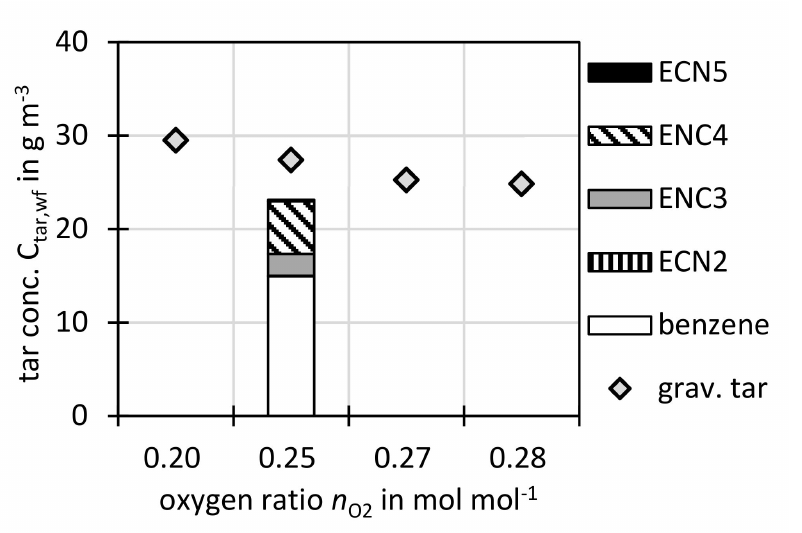
Figure 6. Gravimetric and GC tar concentrations dry, N 2 -free and STP basis at different oxygen ratios n O2 and constant ϑ